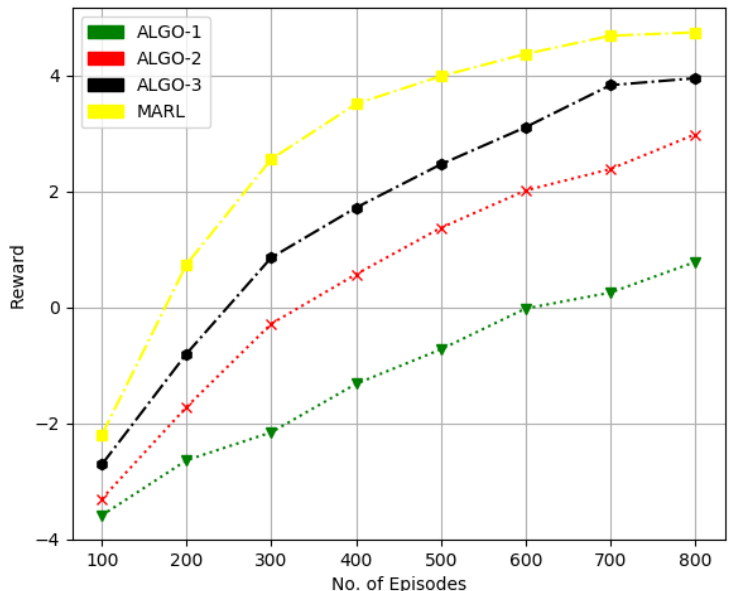
Figure 7. Performance comparison in terms of sumrate for 10 users, four receive antennas at BS and one transmit antenna at each user.